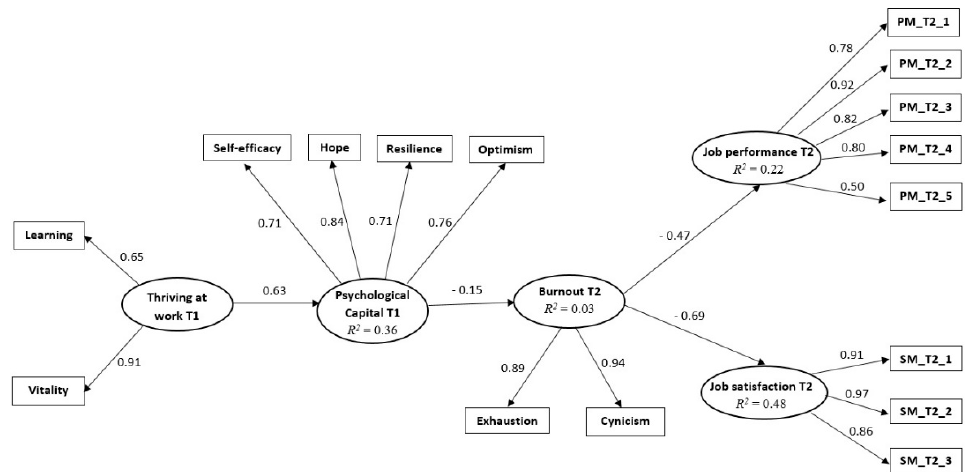
Figure 1. The results for the hypothesized model. Note: The standardized coefficients are illustrated.